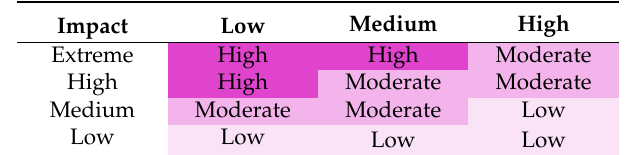
Table 6. Level of Vulnerability Derived From Combining Impact Risk and Adaptive